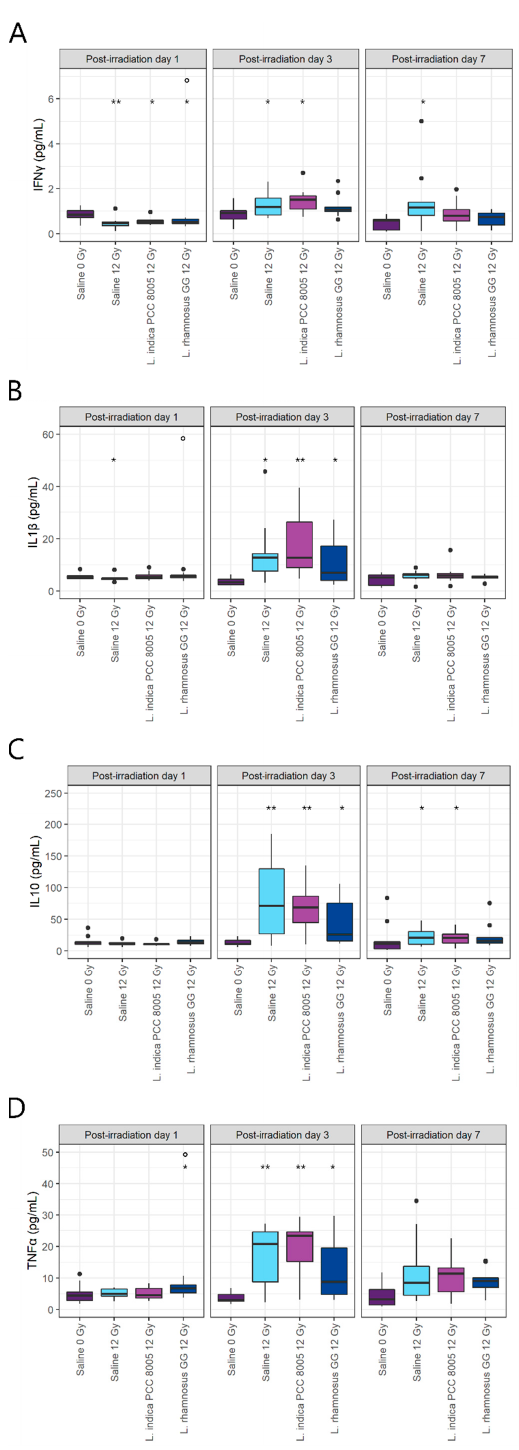
Figure 7. Ileal pro-inflammatory cytokine levels including ( A ) IFN γ , ( B ) IL1 β , ( C ) IL10 and ( D ) TNF α following (sham-)irradiation. Outliers are depicted by dots, n = 10 per group, * p < 0.05 and ** p < 0.01 for pelvic irradiation-induced differences in respect to sham-irradiation, and ◦ p < 0.05 for supplementation-induced differences in respect to saline treatment by Kruskal–Wallis test (Dunn’s post hoc